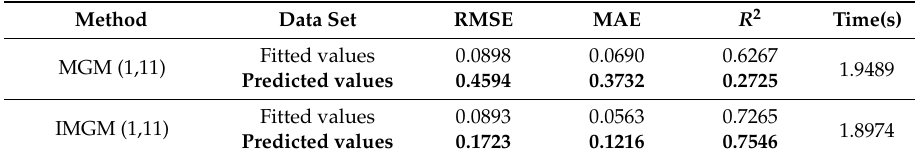
Table 11. Comparison of forecasting evaluation indexes of MGM (1,11) and IMGM (1,11) for the current signal.